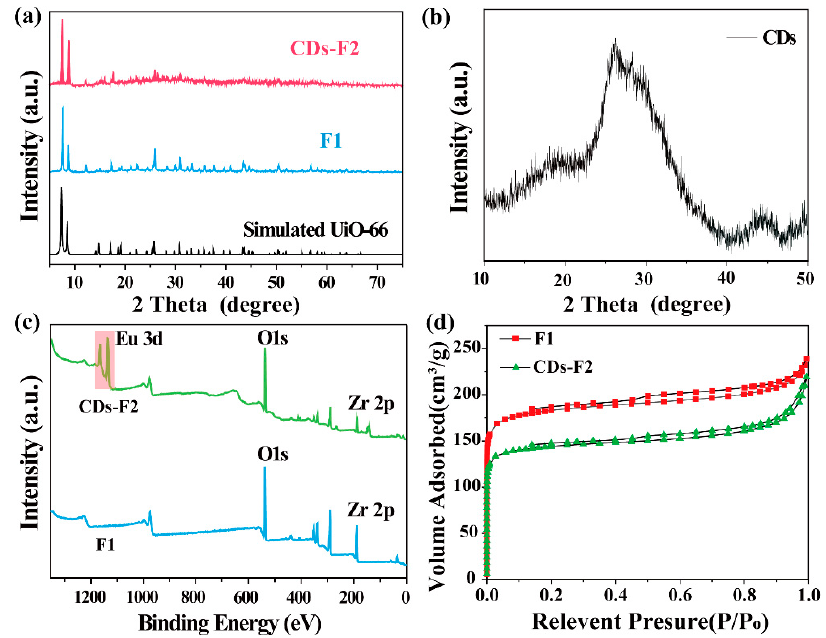
Figure 2. ( a ) PXRD patterns of simulated UiO-66 and as-prepared F1, CDs-F2, and ( b ) CDs. ( c ) XPS spectra of F1 and CDs-F2. ( d ) The N 2 adsorption isotherms of F1 and CDs-F2. spectra of F1 and CDs-F2. ( d ) The N 2 adsorption isotherms of F1 and